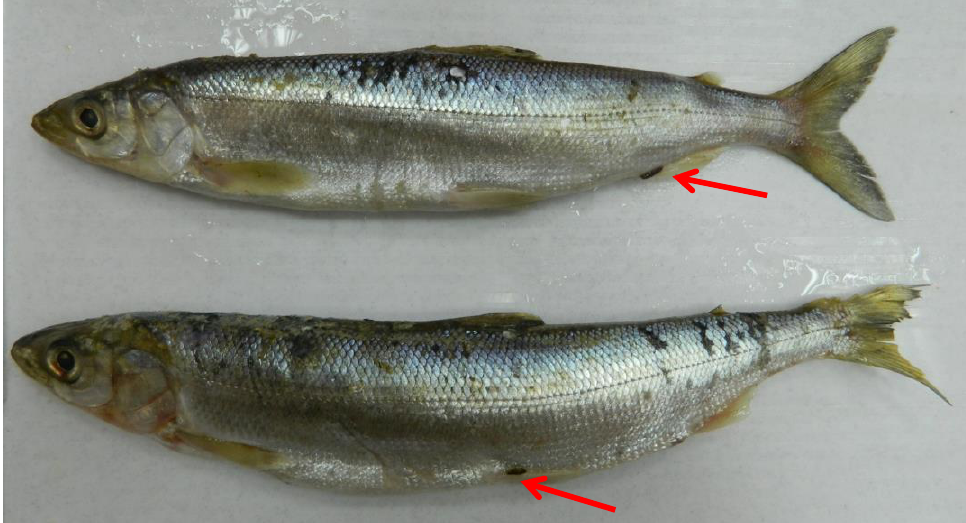
Figure 2. The unfrozen Selenga omul with ectoparasite leeches attached to the anal fin. Amongst the 663 omul fishes available for morphological measurements, the sex ratio of females to males was 1:2. The results of detailed measurement are given in Table